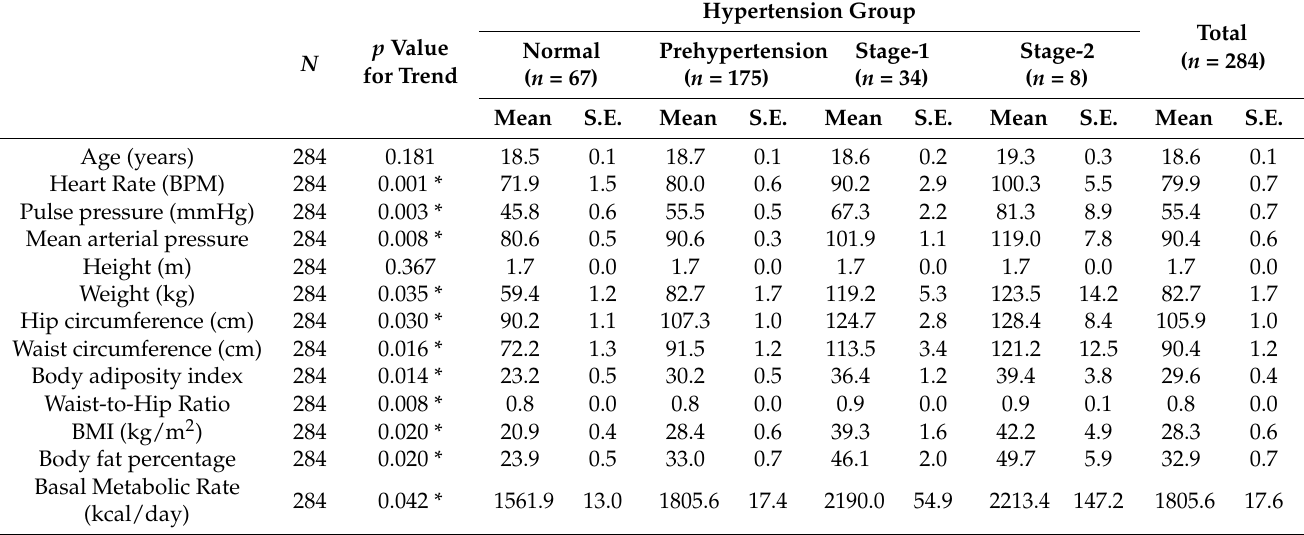
Table 2. Characteristics of participants by hypertension group.